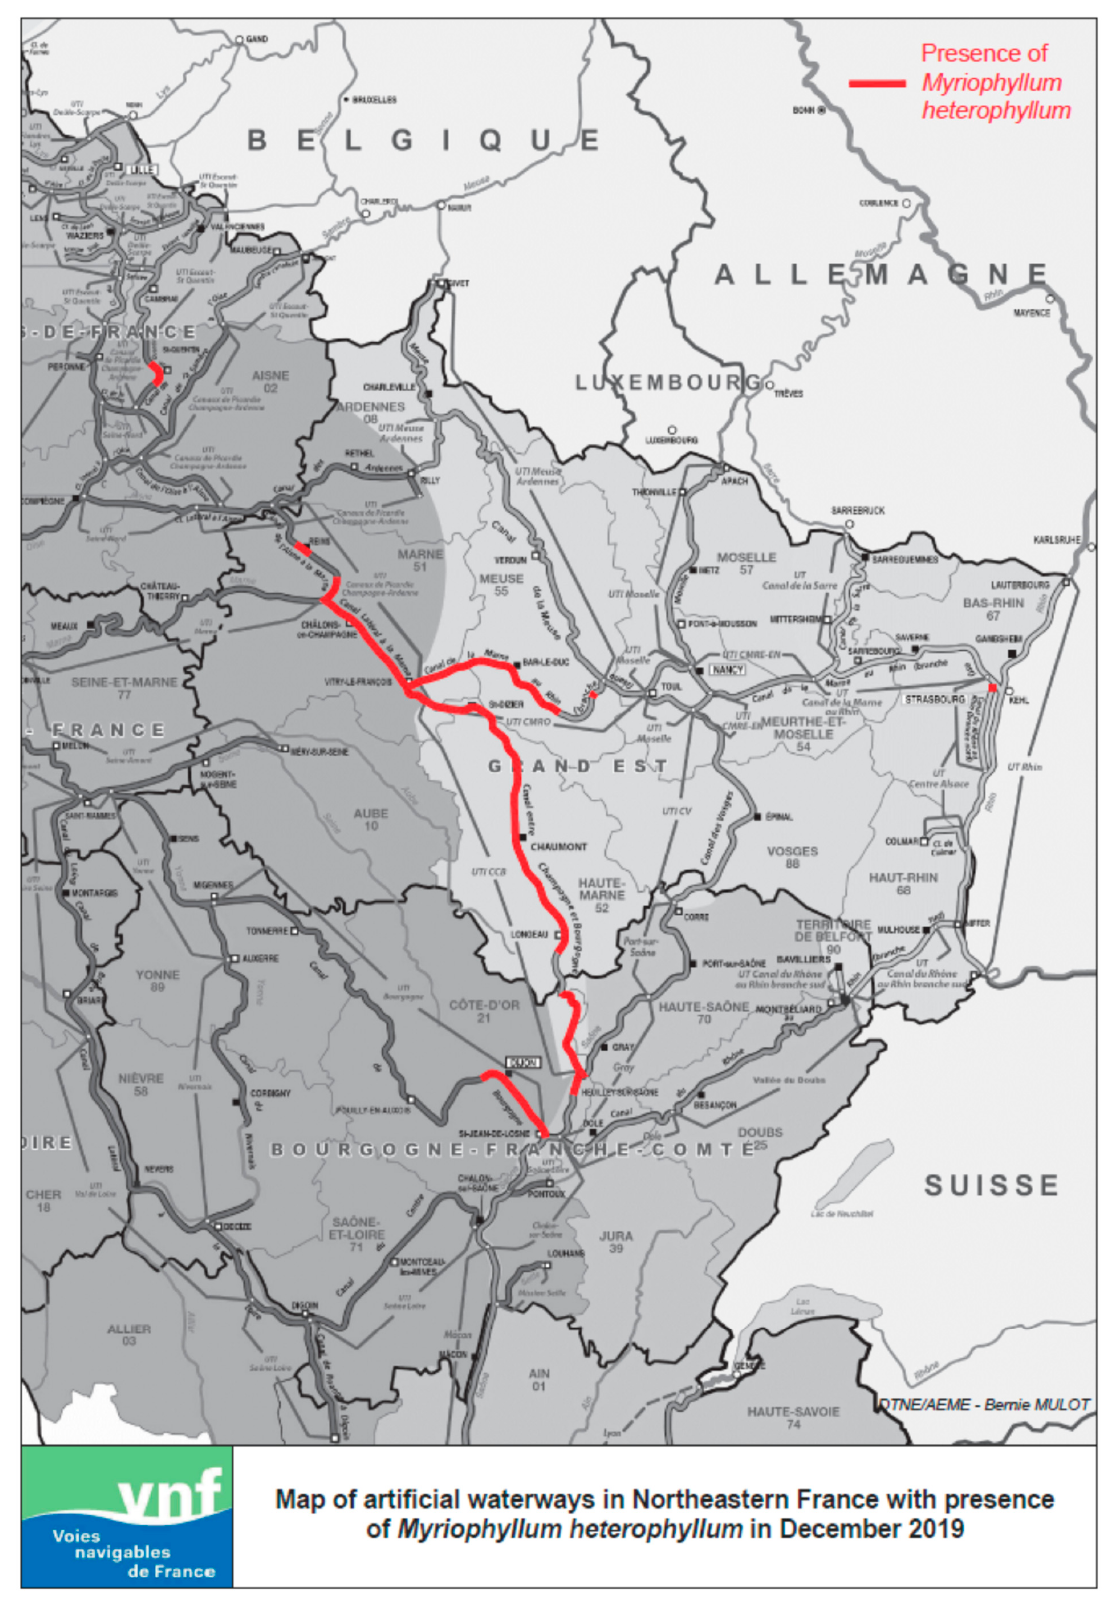
Figure 2. Presence of Myriophyllum heterophyllum in navigation channels in Northeast France as of December 2019, based on own observations or reported findings. Map established by C.